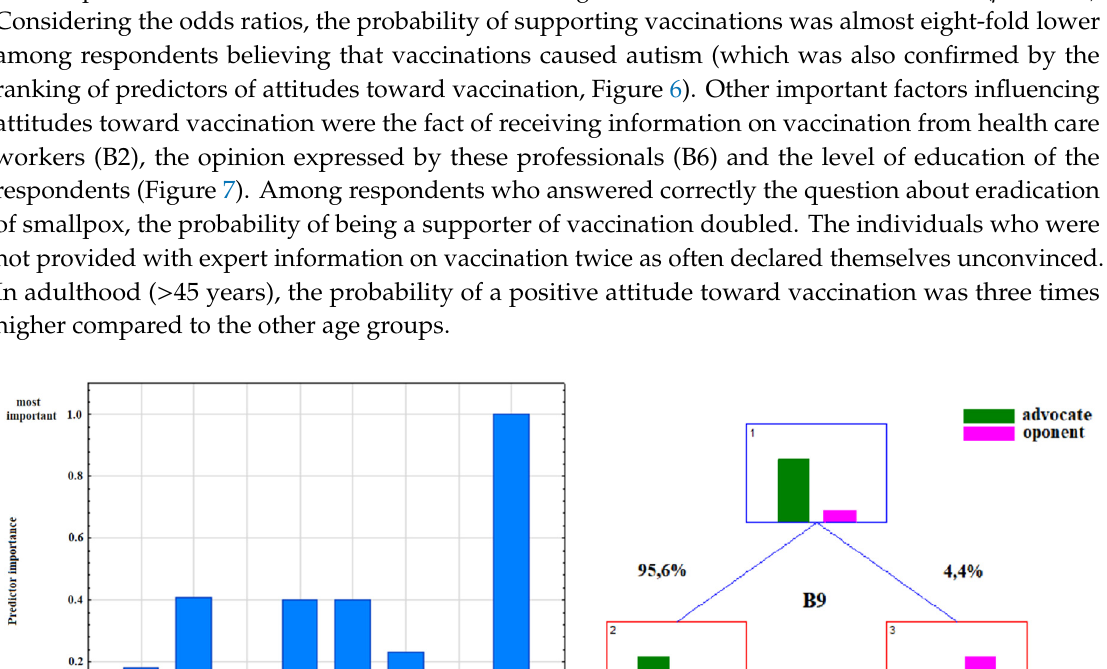
Figure 5. Mean rank ‐ answer to the question about the attitude toward vaccination (B8) + SD depending on the opinion about the relationship between vaccines and autism (B9). Answers to B9: TRUE n = 299; FALSE n = 4410.